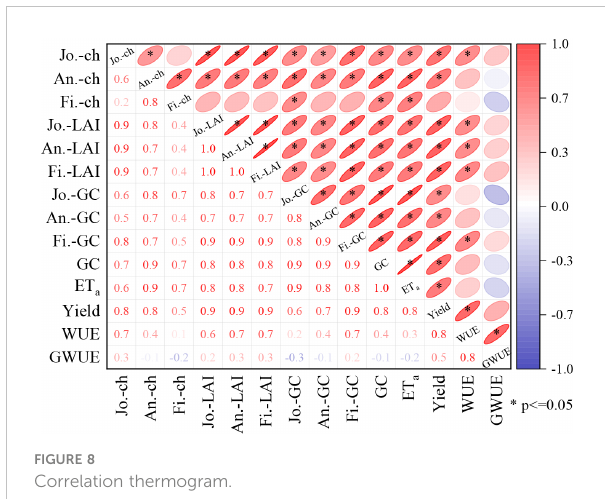
FIGURE 8 Correlation